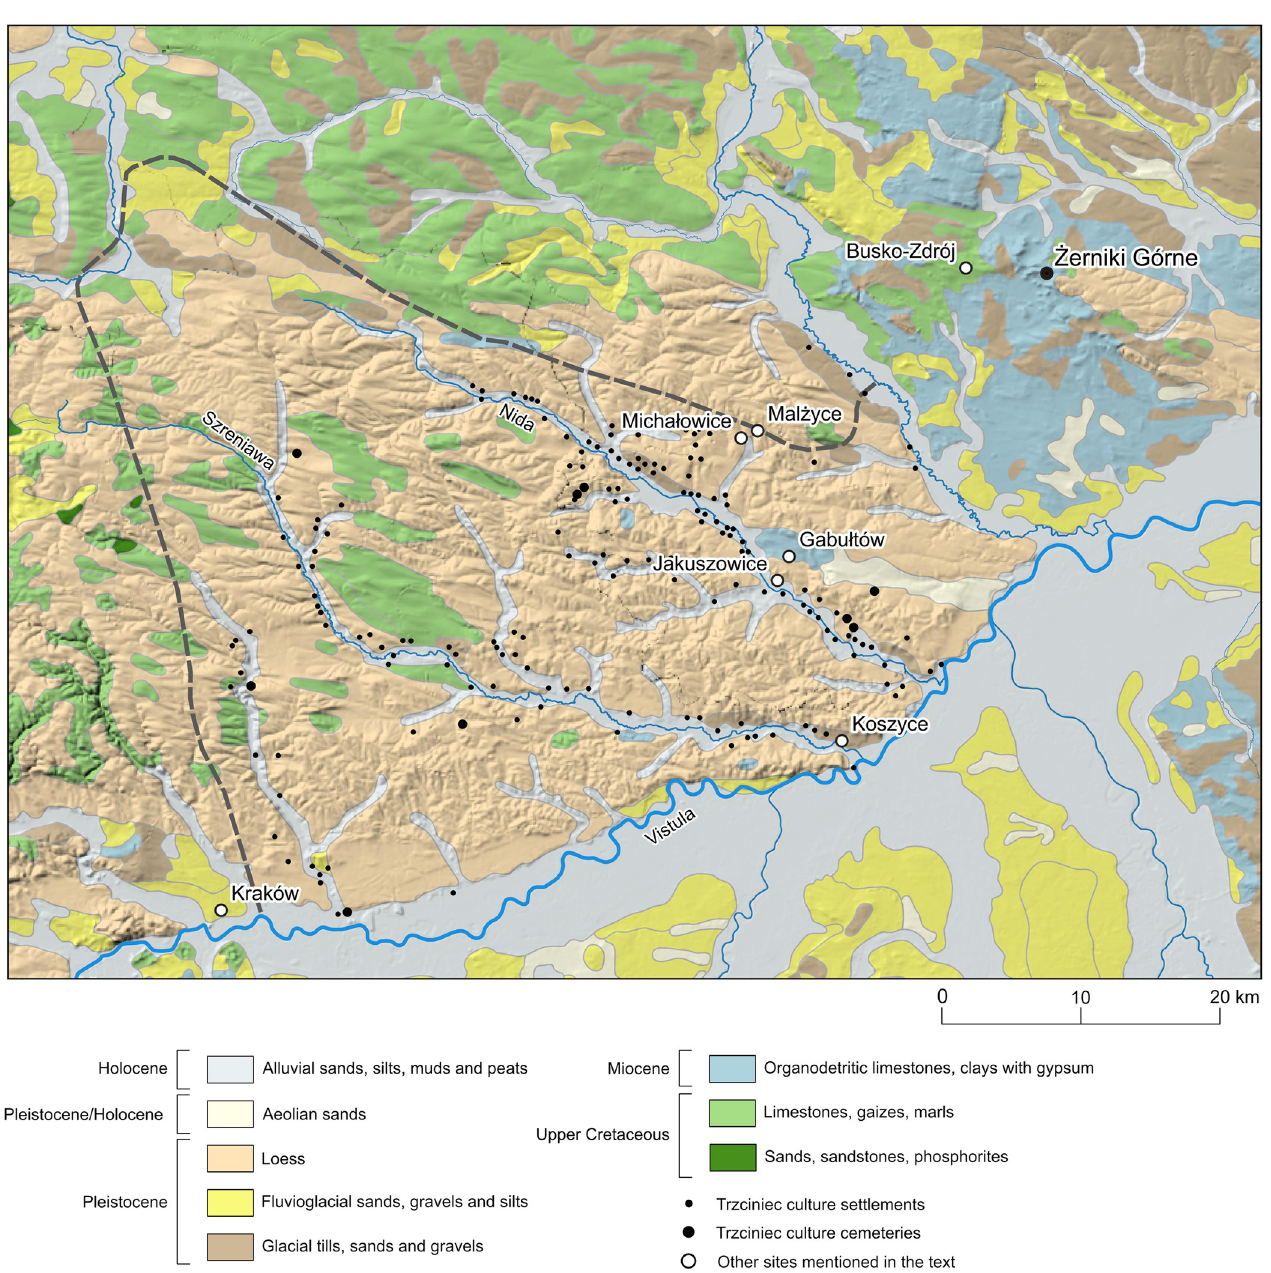
Fig 5. Geological map of southern Nida Basin with location of Ż erniki Go´rne, other cemeteries and settlements of the Trzciniec cultural circle societies, and other sites mentioned in this study. The map was produced with the QGIS 3.26.0 software, based on data from the Geological Map of Poland [129], and on data downloaded from https://www.hydrosheds.org/products/hydrorivers (License Agreement) and https://geoportal.gov.pl/. Note that area systematically surveyed by archaeologists is marked by grey dashed line and it does not include the surroundings of Ż erniki Go´rne.